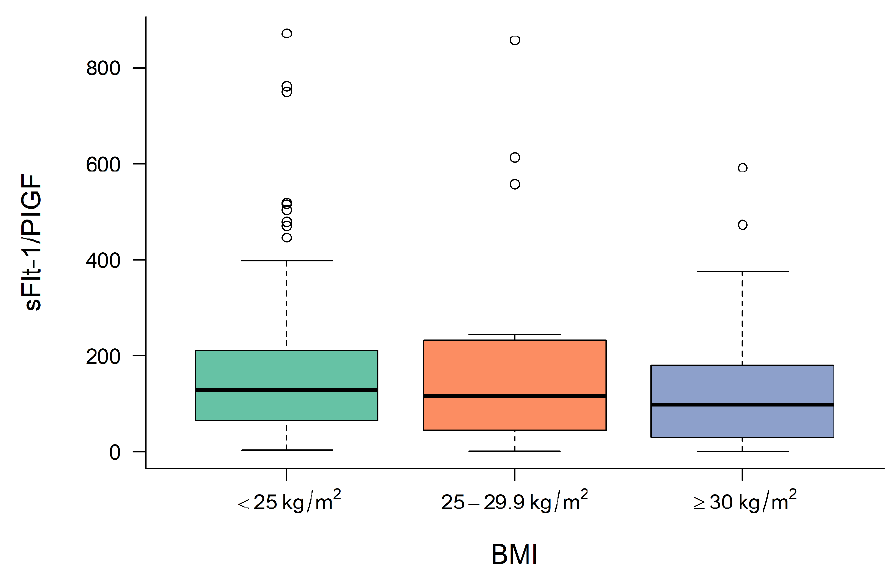
Figure 1. Level of sFlt-1/PIGF at diagnosis in normal-weight, overweight and obese women. BMI body mass index, sFlt-1 soluble fms-like tyrosine kinase-1, PIGF placental growth factor.